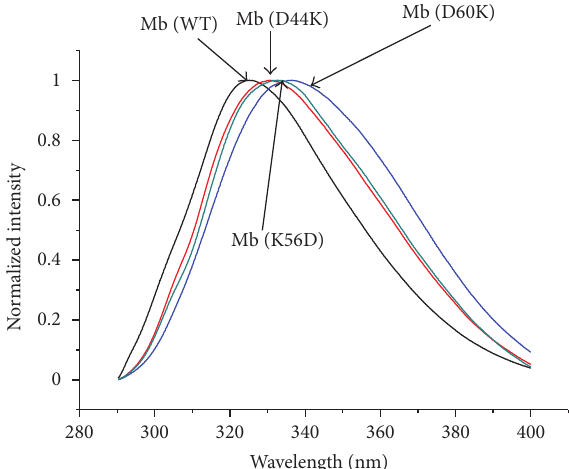
F 8: Fluorescence spectra of 5